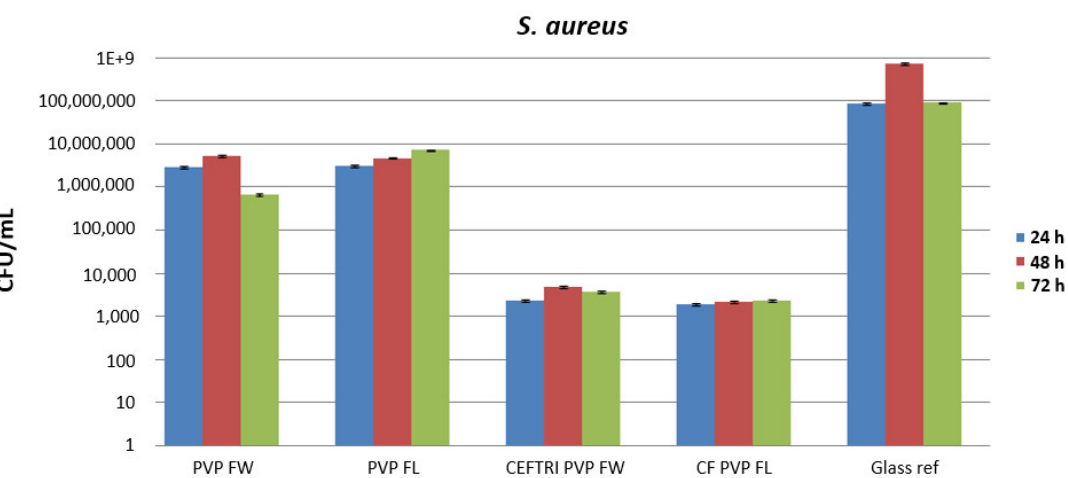
Figure 7. Biofilm formation results of the S. aureus tested strain, developed on nanomodified surfaces MAPLE-deposited at